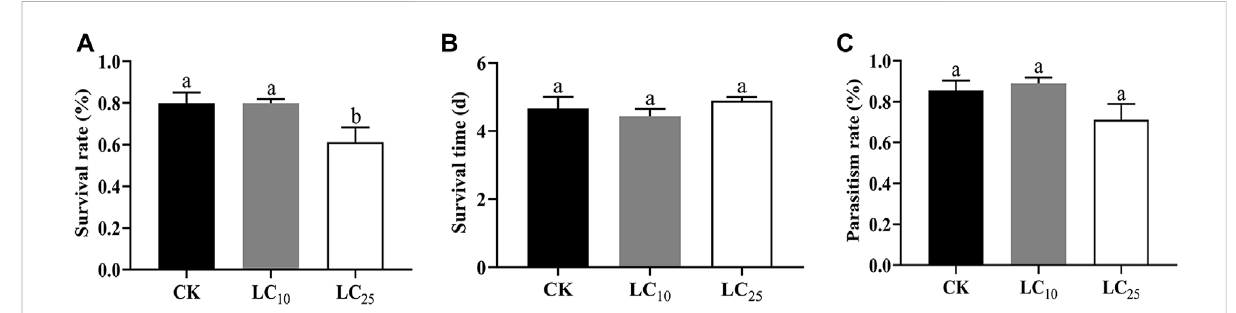
FIGURE 2 Transgenerationaleffectsofsublethaldosesof fi pronilonoffspringof Binodoxyscommunis .Note, (A) survivalrateof Binodoxyscommunis ; (B) survival days; (C) parasitism rate; Columns (Mean ± SE) with the same letters are not signi fi cantly different (Duncan test; p > 0.05).